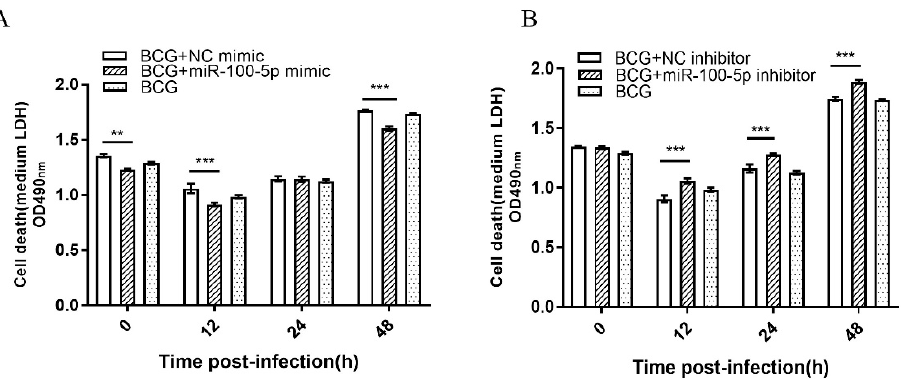
Figure 2. miR-100-5p inhibits LDH release after BCG infection. LDH assay in THP-1 cells transfected with NC mimic, miR-100-5p mimic ( A ) or NC inhibitor, miR-100-5p inhibitor ( B ) and infected with BCG (MOI = 10) for 8 h. Cell death was detected by medium LDH release assay at 0, 12, 24, and 48 hpi. Data are from three independent experiments with biological duplicates in each (( A , B ); mean ± s.e.m. for n = 3 duplicates). ** p < 0.01; *** p < 0.001.